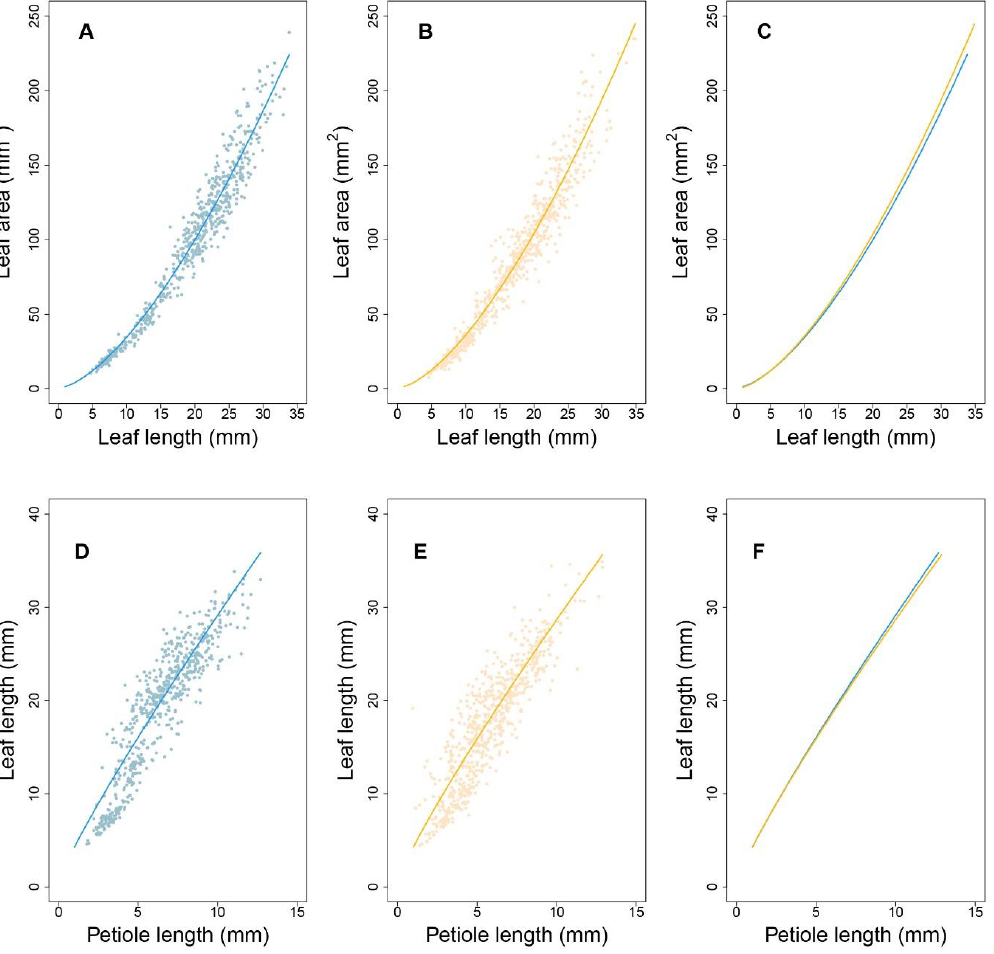
Figure 3. Fitness of allometric growth with different traits of leaf. (A) and (B) are the allometric pattern between the leaf length and leaf area, respectively, for high- and low-density conditions. (D) and (E) are the pattern between the petiole length and leaf length for high- and low- density conditions. (C) and (F) are the comparison of the mean allometric curve fitted for leaf length – leaf area and petiole length – leaf length, respectively.